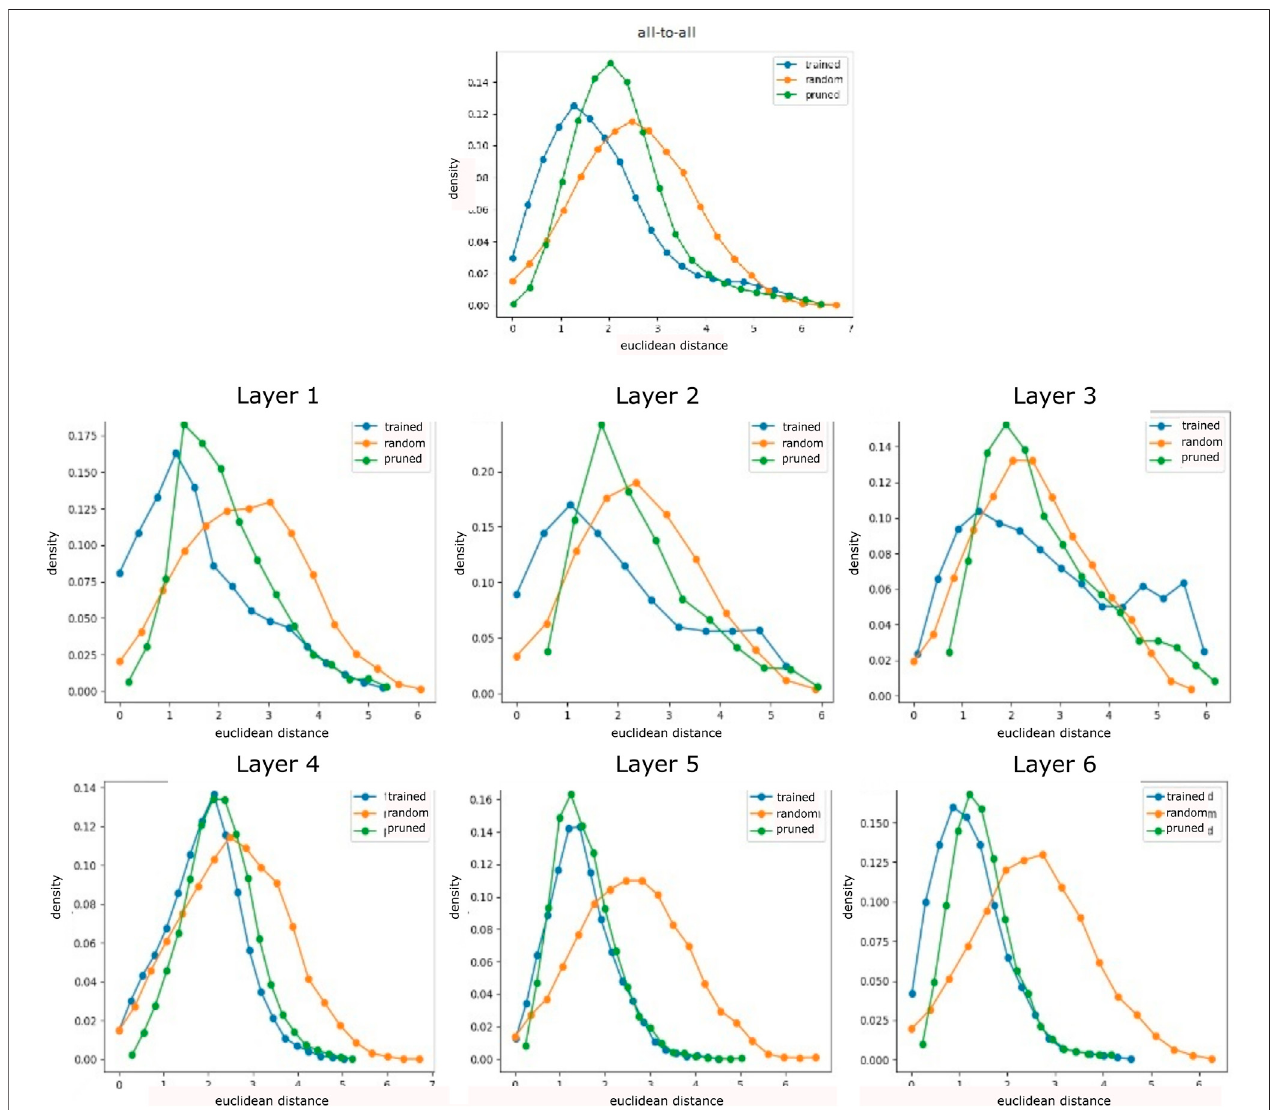
FIGURE2| Neuron activationanalysisforrandomlyinitialized,trained, andprunednetworks onathree-jointmanipulator (averages over500 sampleepisodesand 20 trained agents). Distance measured between all-to-all (all neurons in a network are correlated among each other, left) neurons and layer-wise (for every neuron only neurons on this layer are considered for correlation, right) indicate a bell-shaped distribution with higher mean in the fi rst and last layer. Pruning sharpens the bell shape, increasing the mean, but reducing very high distance scores.